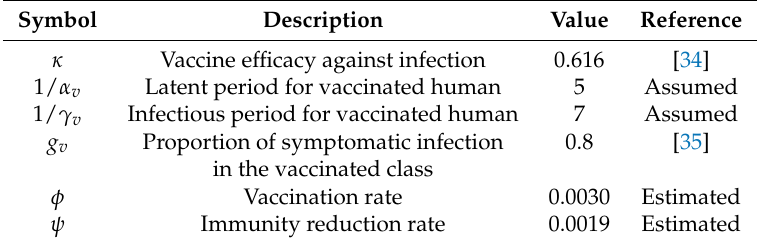
Table 2. Descriptions and values of parameters used in the model